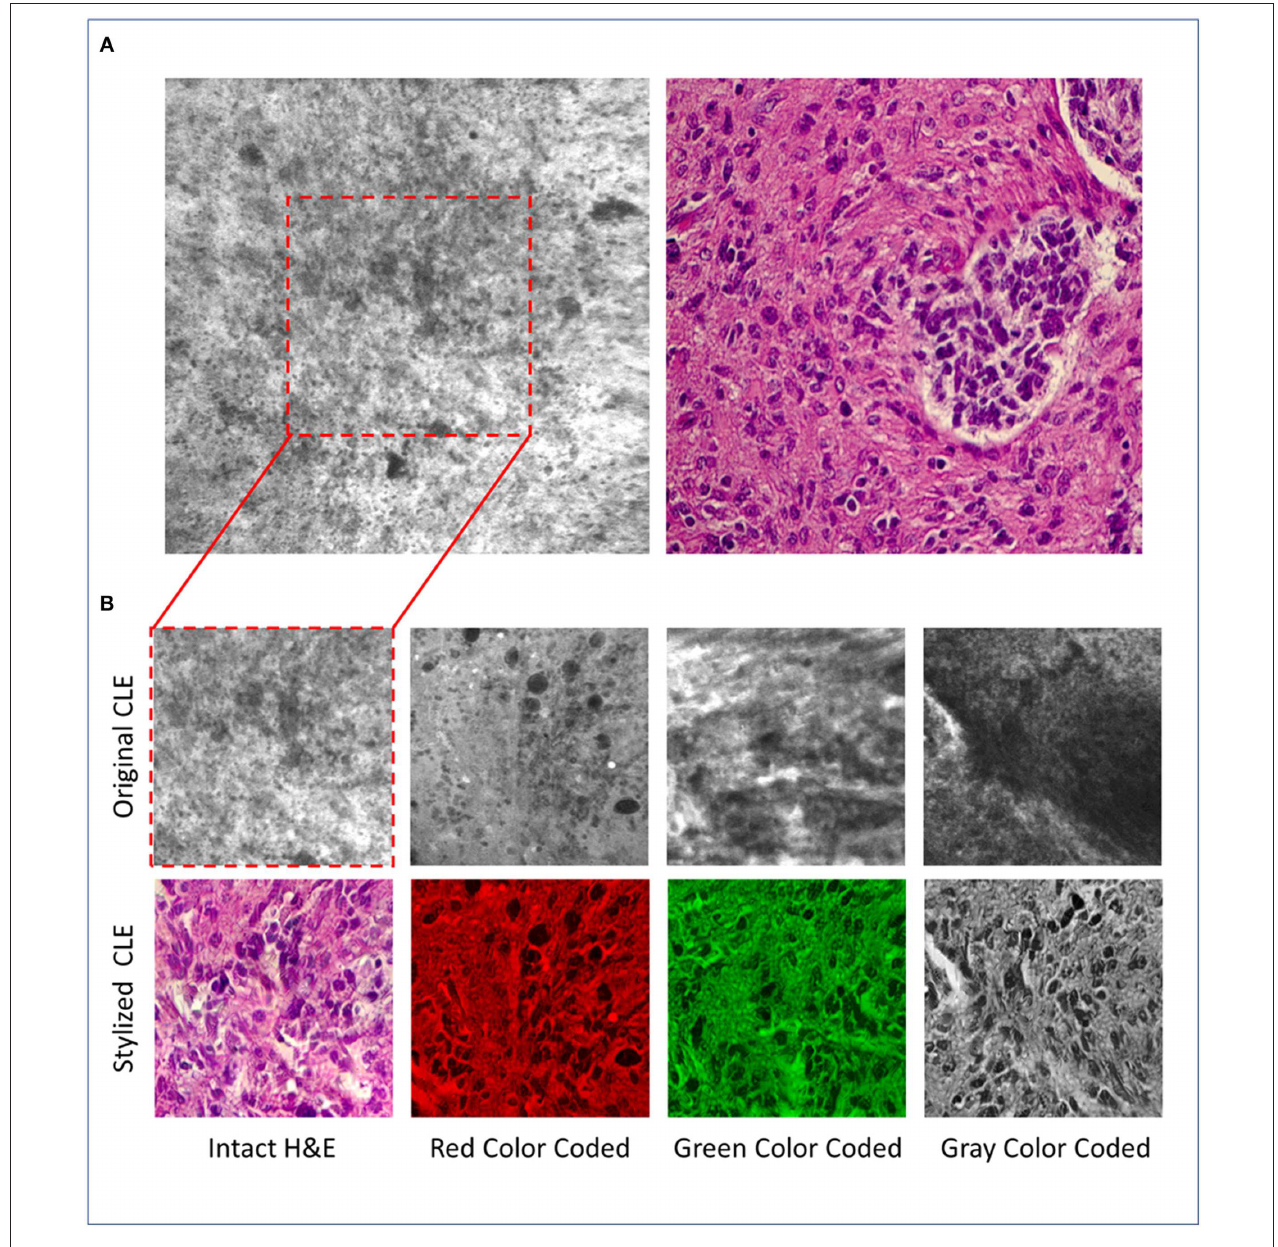
FIGURE 1 | (A) Representative CLE (Optiscan 5.1, Optiscan Pty., Ltd.) and H&E images from glioma tumors. (B) Original and stylized CLE images from glioma tumors, in 4 color coding: gray, green, red, intact